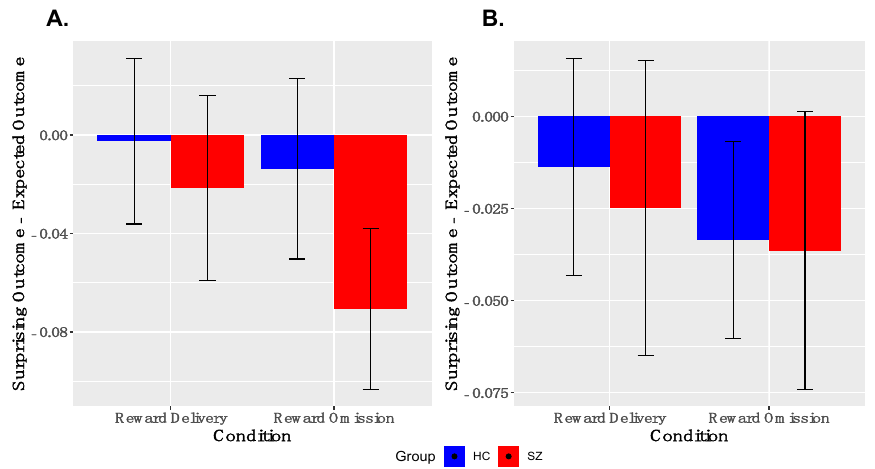
Figure 3. Ventral Striatal Signaling to Prediction Error: ANOVA responses to surprising reward omis- sion, but not surprising reward deliveries, is evidenced in both left, ( A ), and right, ( B ) ventral stria- tum (y = 8). No between-group differences were observed. SZ, schizophrenia; HC, healthy control.